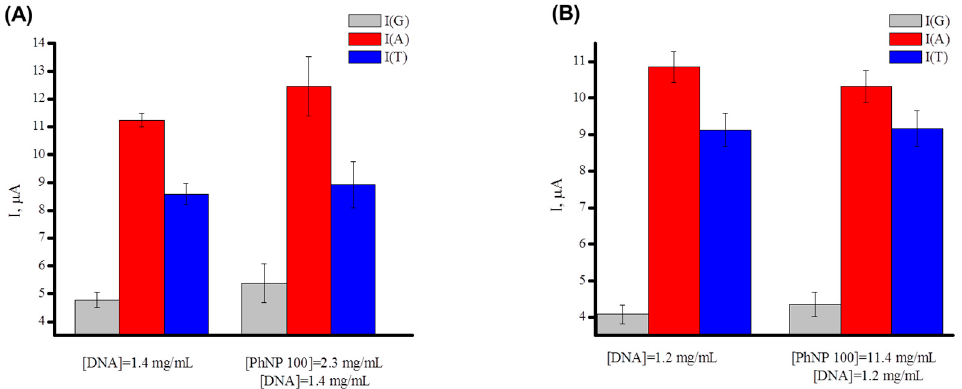
Figure 3. Histograms corresponding to the maximum peak current of dsDNA oxidation registered by DPV in the absence and presence of PhNP100 at concentrations of ( A ) 2.3 mg/mL and ( B ) 11.4 mg/mL on SPE/CNT.